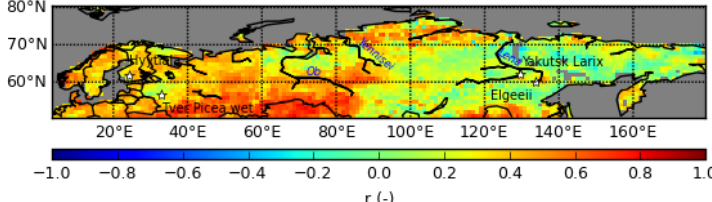
Figure 4. The temporal correlation coefficient of SiBCASA and ASCAT soil moisture for all August months in the period 2007–2013 (7 years × 31 days).